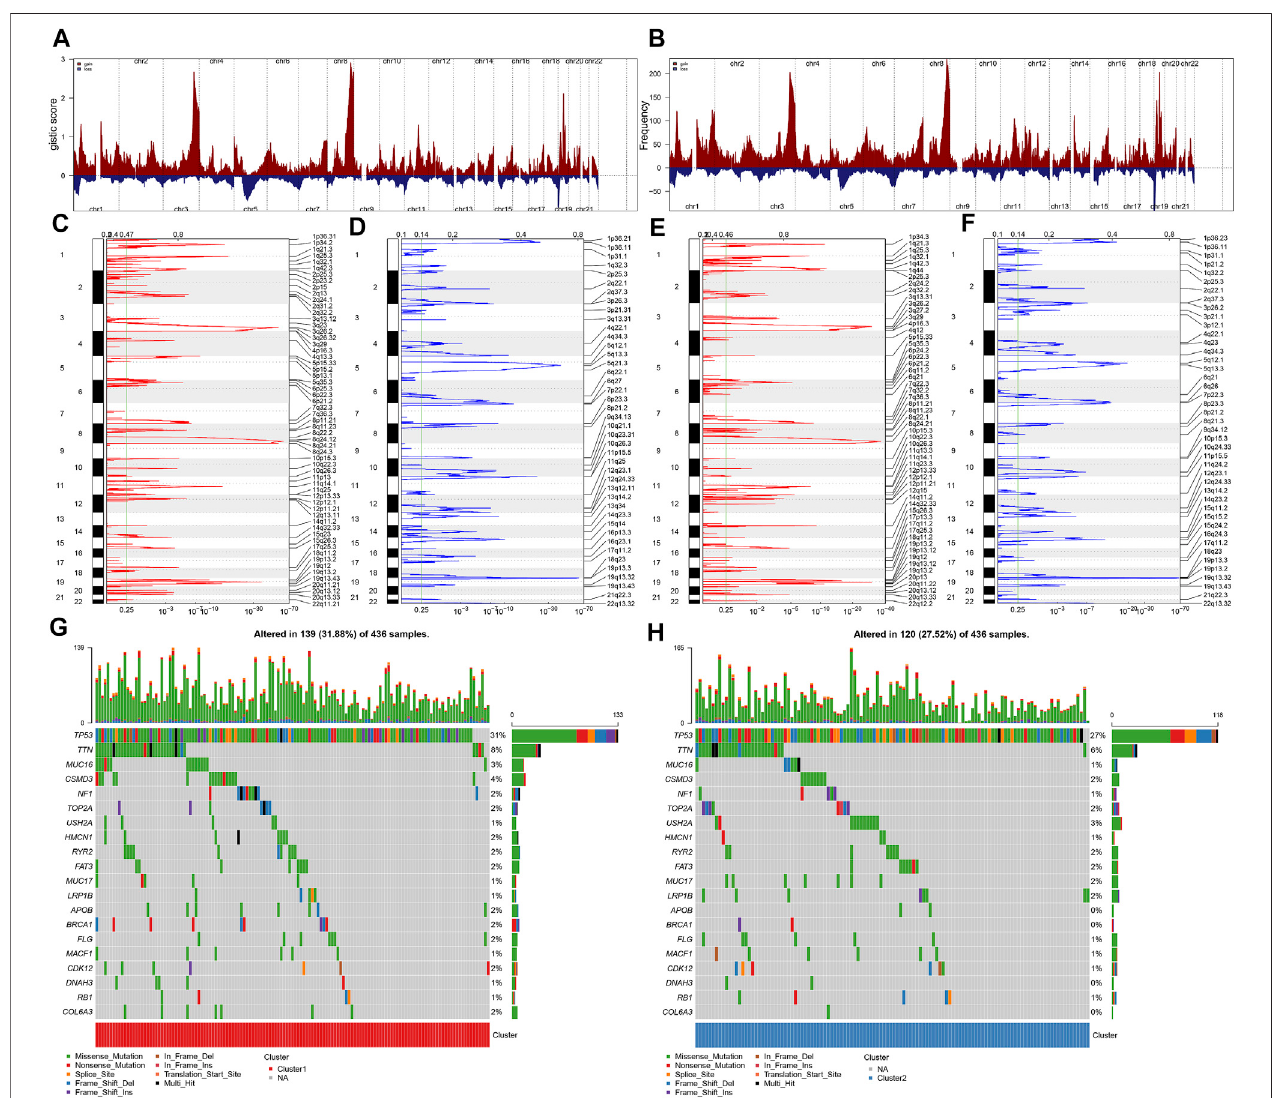
FIGURE 2 | Immune subtypes with diverse genomic variations across OC. (A,B) Landscape of the GISTIC score and frequency of signi fi cant ampli fi cations (red) and deletions (blue) across OC specimens with GISTIC2.0 software. Red meant ampli fi cation, whereas blue meant deletion. (C,D) Prominently ampli fi ed and deleted fragmentsinimmunesubtype1. (E,F) Prominentlyampli fi edanddeletedfragmentsinimmunesubtype2.The q valueandscorecalculatedbyGISTIC2.0forvariations( x axis) were depicted corresponding to the genome locations ( y axis). The dotted lines indicate centromeres. The green lines meant q value threshold to determine signi fi cantly mutated genes. (G,H) Oncoprint of the somatic mutation landscape across OC specimens from (G) immune subtype 1 and (H) immune subtype 2.